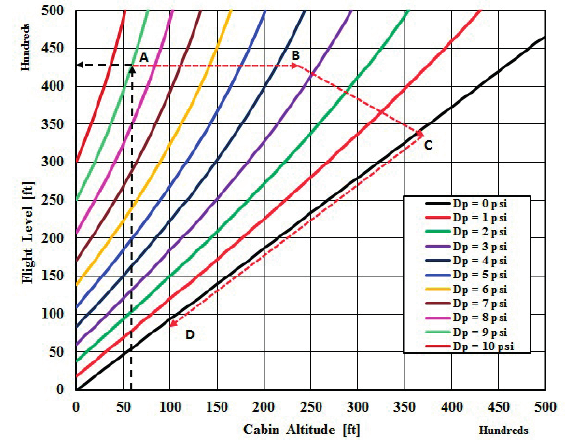
Fig. 5. ED dynamics with an ISOAM cabin and environmental atmospheres. Not to scale